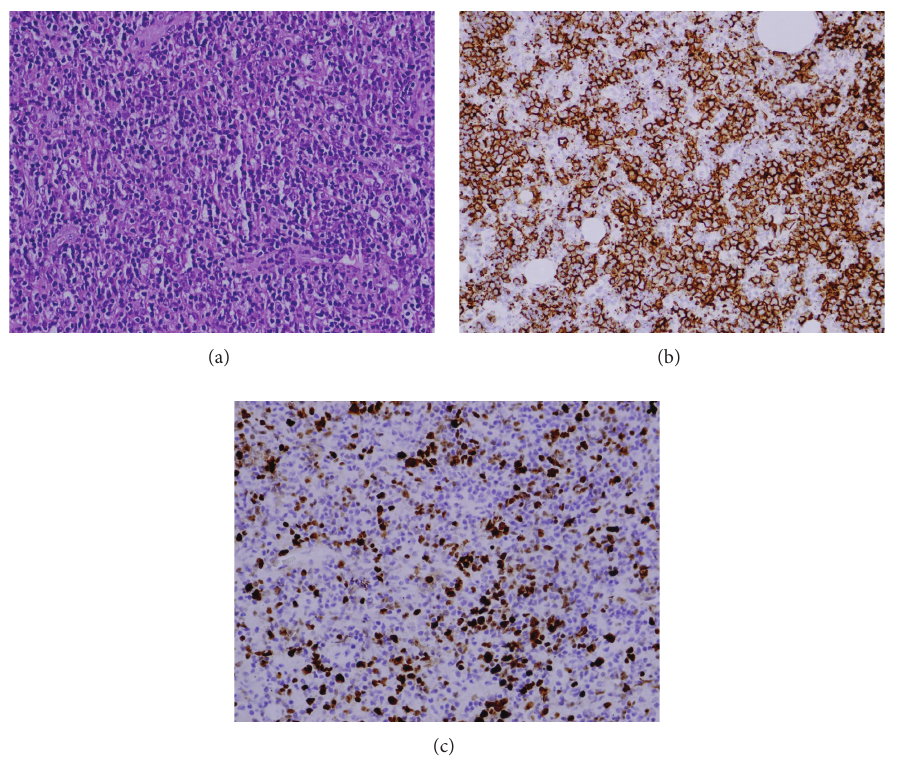
Figure 2: (a) Large atypical cells between small lymphoid cells (HE × 400). (b) CD 20 positivity ( × 400). (c) Ki 67 proliferation index was 60% ( ×